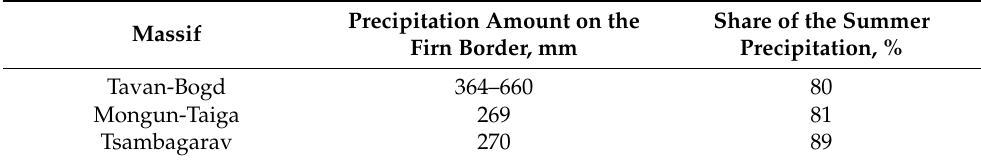
Table 5. Precipitation amount and share of the summer precipitation in research areas. Precipitation Amount on the Share of the Summer Massif Firn Border, mm Precipitation, % Tavan-Bogd